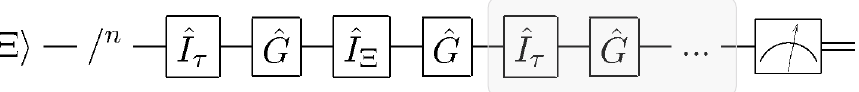
Figure 3: The quantum circuit implementing a variant of the Grover’s algorithm general- ized for arbitrary (including partial) initial superposition. Only memory register ( n qubits) is employed. ˆ I τ is the quantum oracle operator, which inverts the phase of the target state τ . Likewise, ˆ I Ξ - inverts phases of all terms originally present in memory. It plays the key role in mitigation the destructive interference of the ghost states spawned by the first Grover’s di ff usion operator. ˆ G - Grover’s di ff usion operator, inverting all amplitudes about their aver- age. ˆ I τ and ˆ G comprise one Grover iteration. The boxed region denotes the Grover’s cycle 2 (introduced later in formula 1) Grover’s containing T j −